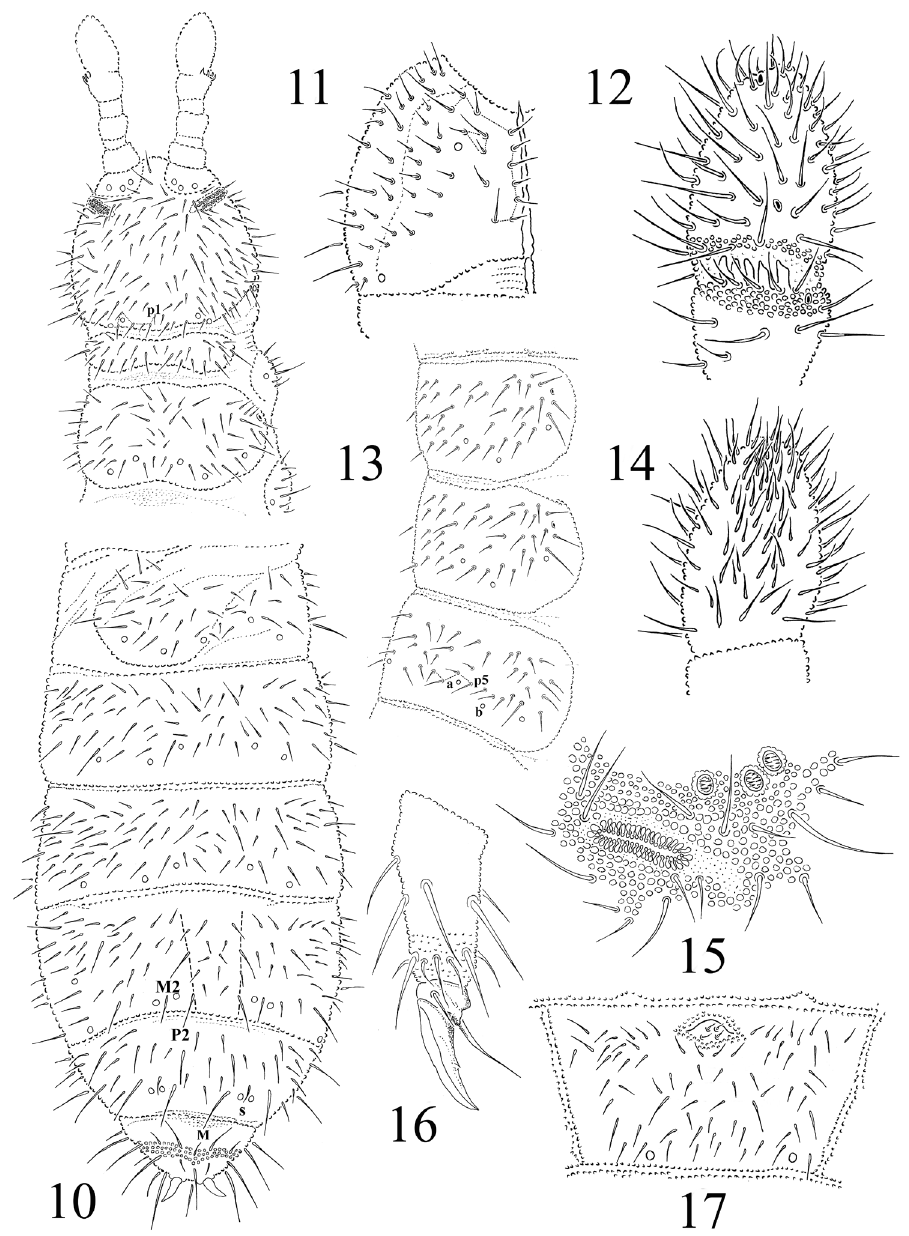
Figures 10–17. Protaphorura jernika : 10 habitus and dorsal chaetotaxy 11 left part of head ventrally 12 dorsal side of Ant. III–IV 13 chaetotaxy of Th. terga I-II aand Abd. tergum I 14 ventral side of Ant. IV 15 PAO and anterior cephalic pseudocelli 16 tibiotarsal chaetotaxy and claw of leg III 17 chaetotaxy of Abd. sternum